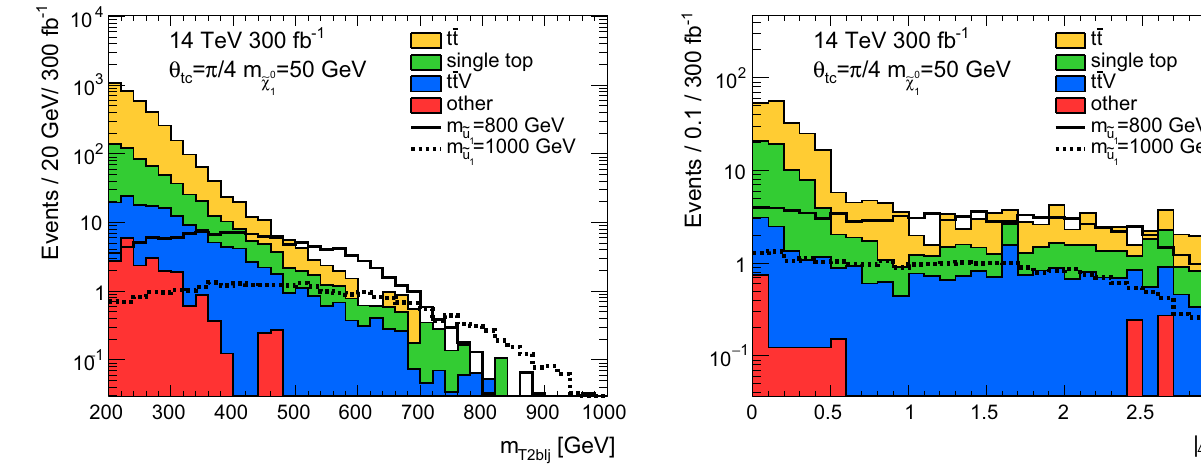
= 50 GeV, θ for m ˜ χ 0 1 1